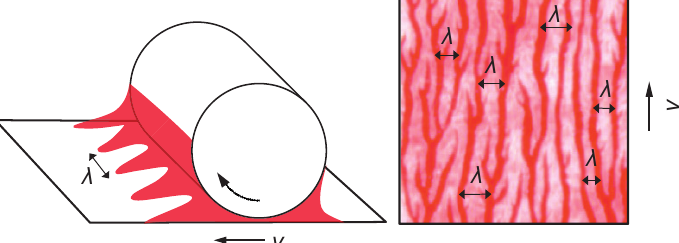
Figure 1. Viscous fingering instability in the printing nip creates ribbing defect on the printed sample. The cylinder revolution and substrate velocity v affects the dominant pattern wavelength λ